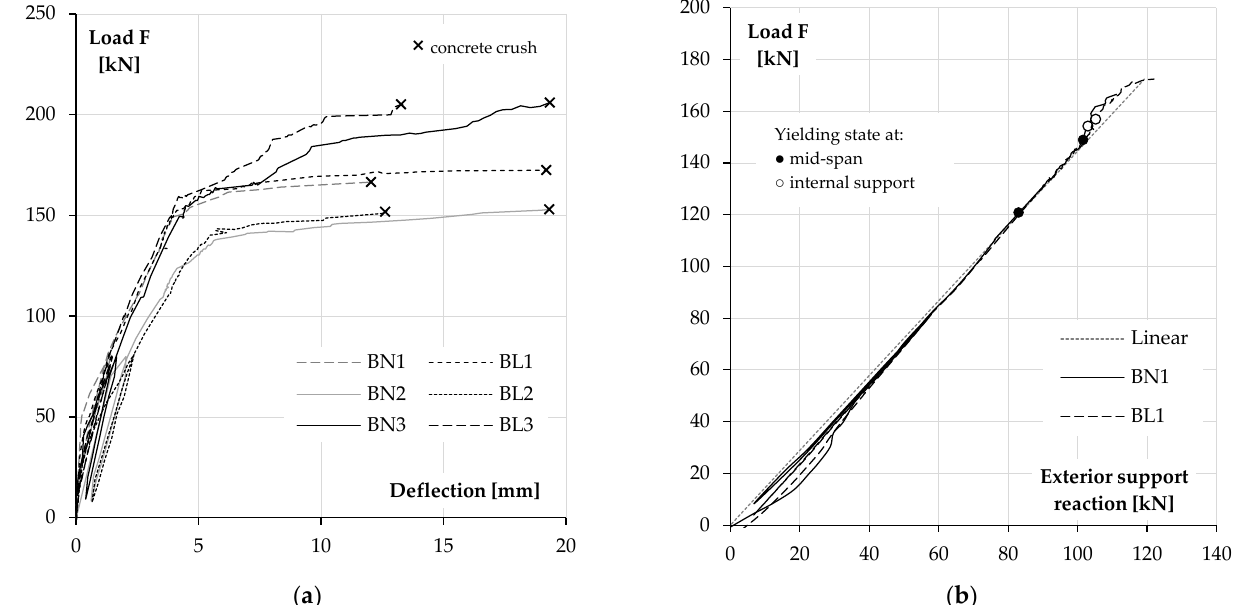
Figure 12. Load – deflection behaviour on NWC and LWAC beams ( a ). Load redistribution at exterior support in the first group (BN1 and BL1) ( b ). Table 7. Redistribution results.